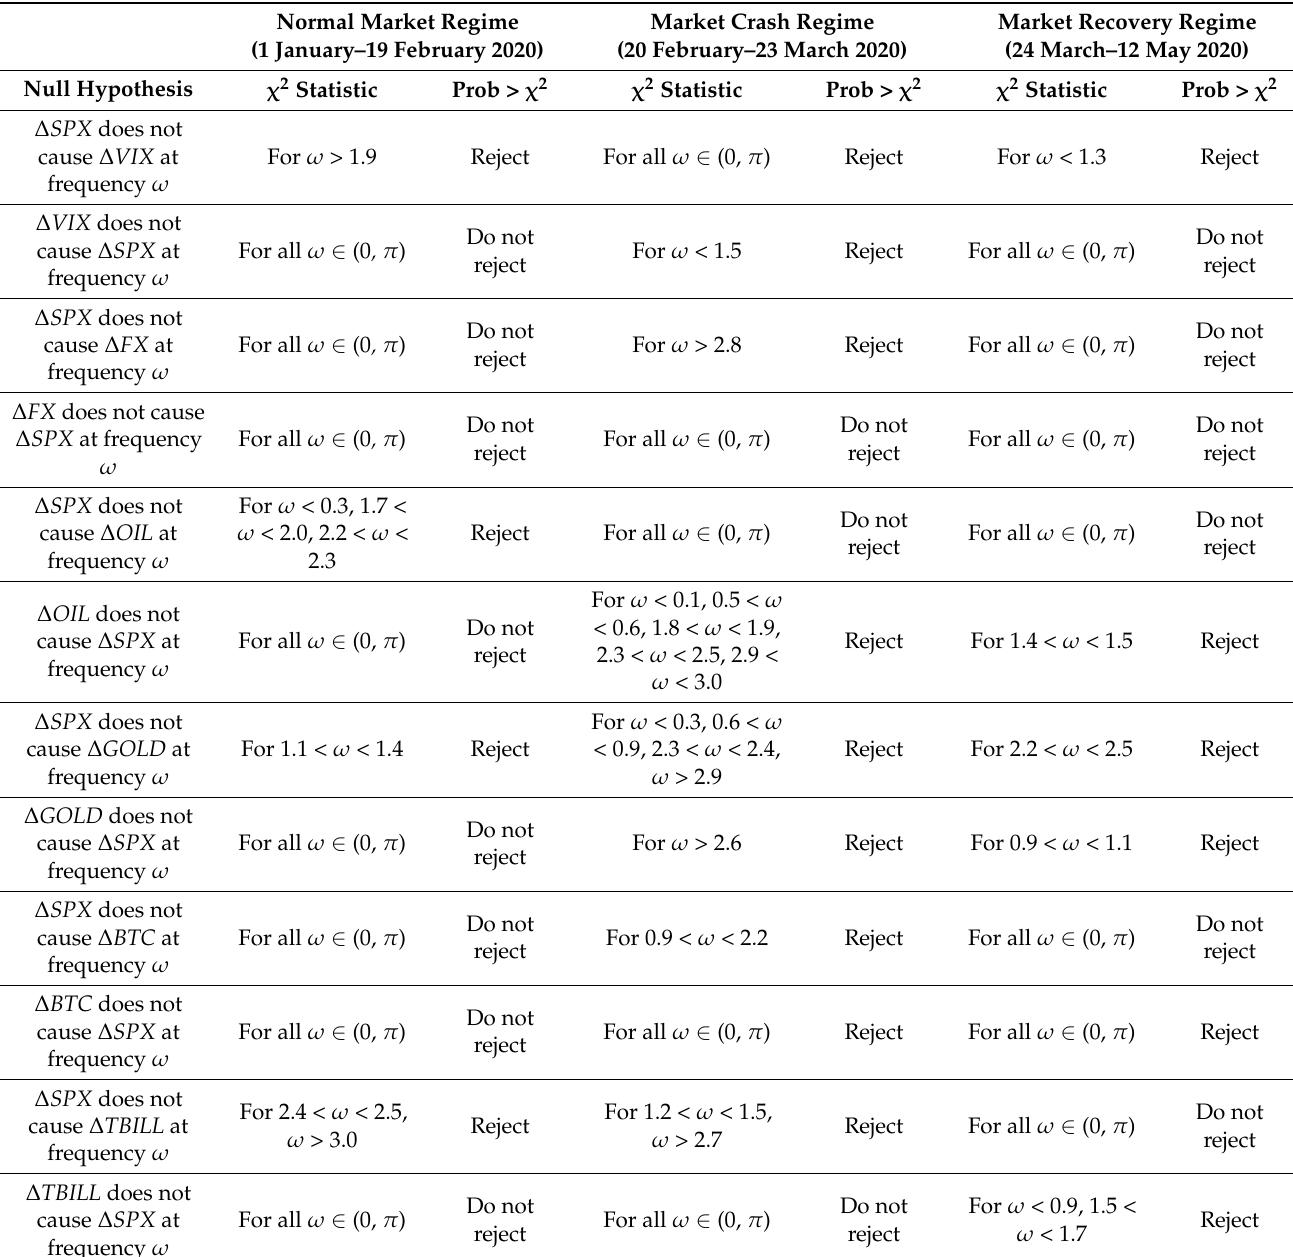
Table 2. Causality